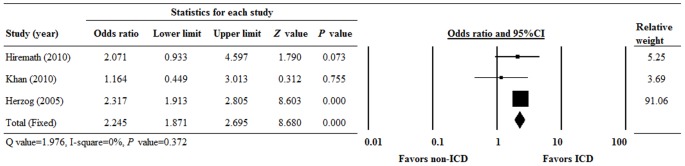
Forest plot of odds ratios (ORs) with 95% confidence intervals (CIs) for overall survival (OS) of the included studies.P<0.05 indicates a statistically significant difference.